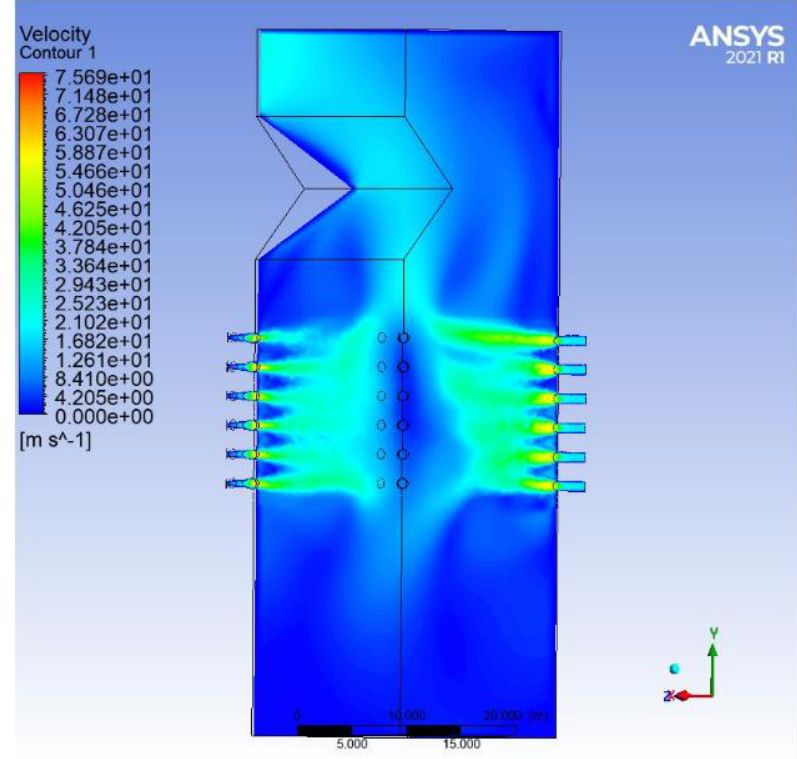
Figure 15. Velocity distribution of flue gas in case-VII.